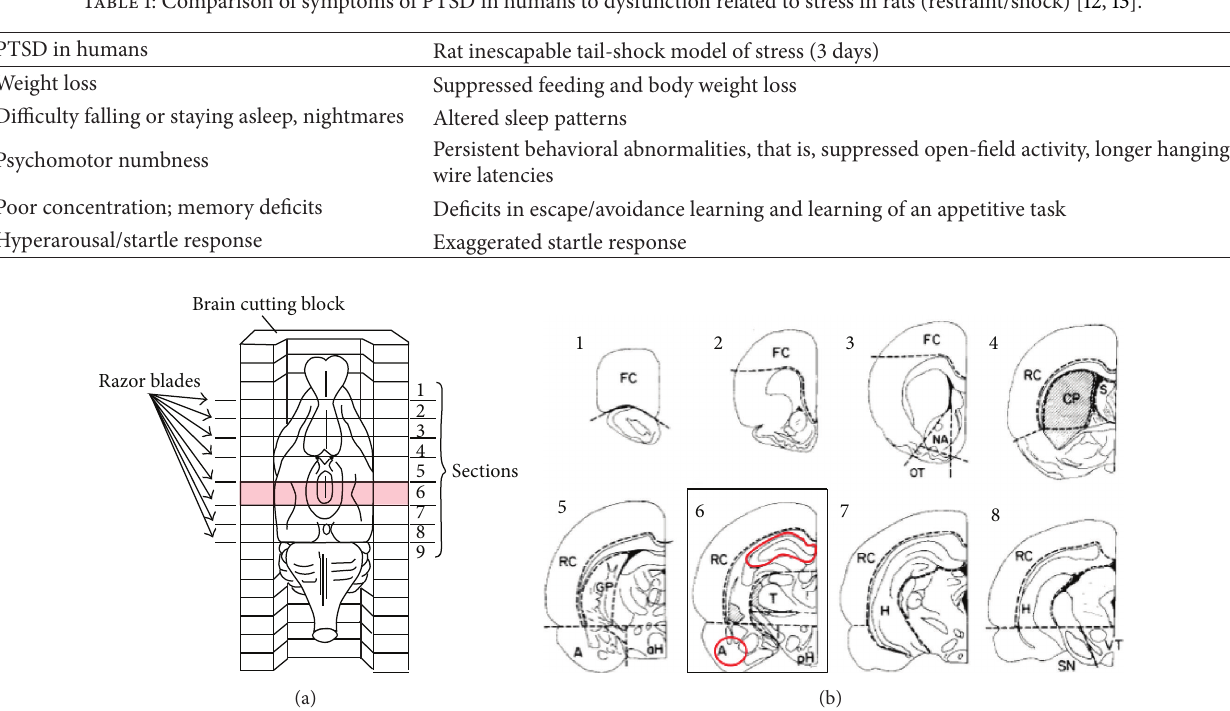
Table 1: Comparison of symptoms of PTSD in humans to dysfunction related to stress in rats (restraint/shock) [12, 13].